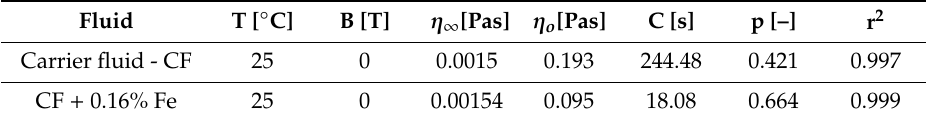
Table 2. Rheological characterization of the carrier fluid and Fe particle suspensions.